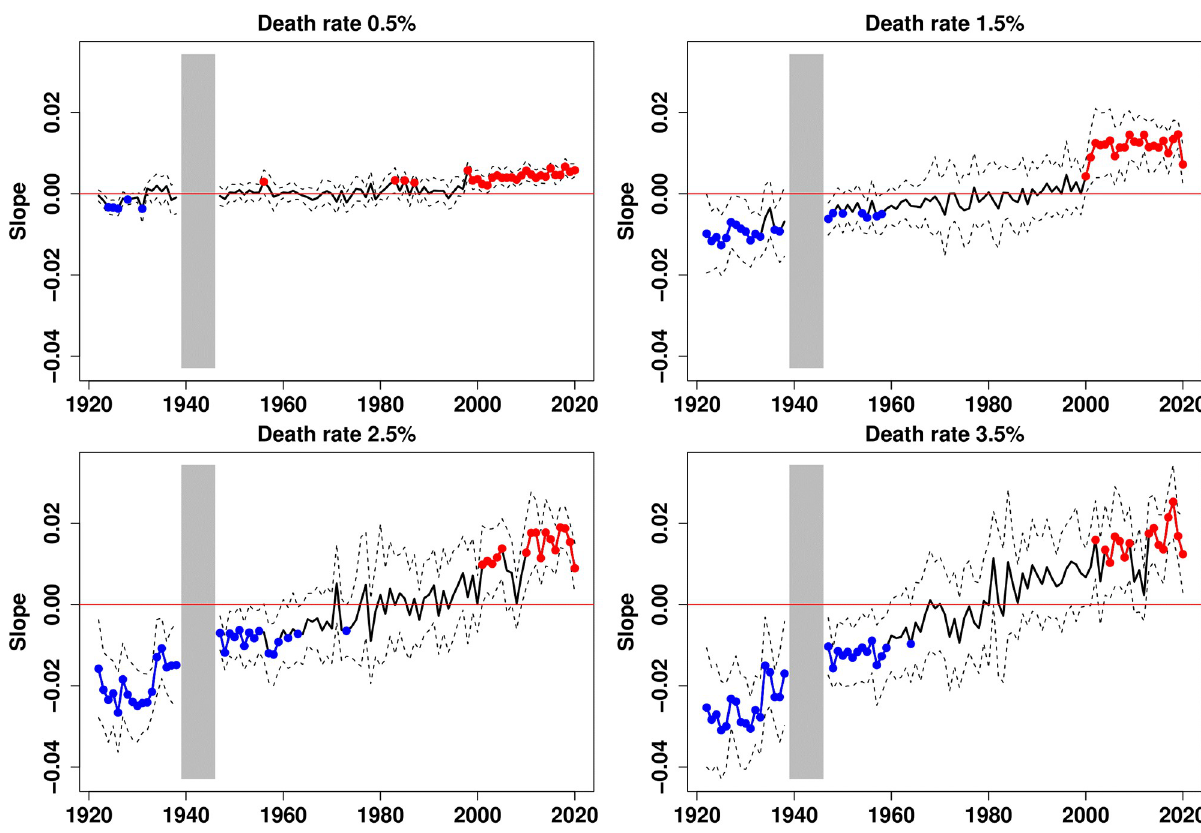
Fig 4. Income gradient in mortality for 4 mortality milestones, 1922–2020. Plain curves plot the estimates of the linear trends across income groups; dotted lines are the 95% confidence intervals. Red dots indicate dates at which the slope is significantly positive, while blue dots indicate those with significantly negative slopes. Gradients are not represented for the period